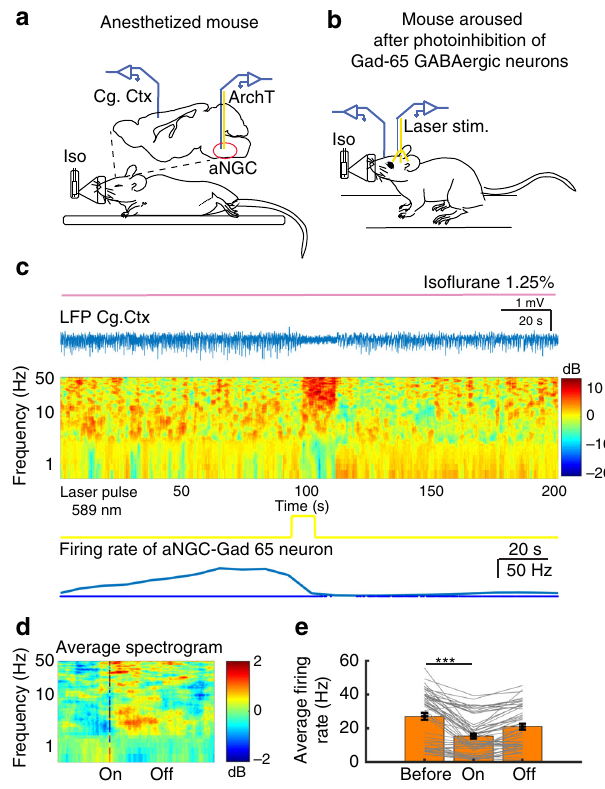
Fig. 4 Photoinhibition of GABAergic aNGC neurons generates cortical and behavioral arousal. a Schematic depicts area of injection of AAV-packaged Cre -inducible light-gated proton pump, ArchT in aNGC and location of electrodes in the cingulate cortex and the optic fi ber in aNGC. b Drawing depicts optogenetic stimulation of an anesthetized mouse (iso fl urane 1.25% vol; pink line). c Photoinhibition of a Gad65 + aNGC neuron (bottom panel) and concurrent desynchronized cortical LFP (raw data). d Average spectrogram of 48 laser pulses obtained from three animals. Color bar represents power in decibels. There is a consistent decrease in slow cortical oscillations and an increase in high frequencies in pulses with effective GAD65 + aNGC cell photoinhibition. e Average instantaneous fi ring rate of GAD65 + cells shows decreased fi ring during photoinhibition (mean± s.e.m.) *** p = < 0.001; one-way ANOVA. Source data are provided as